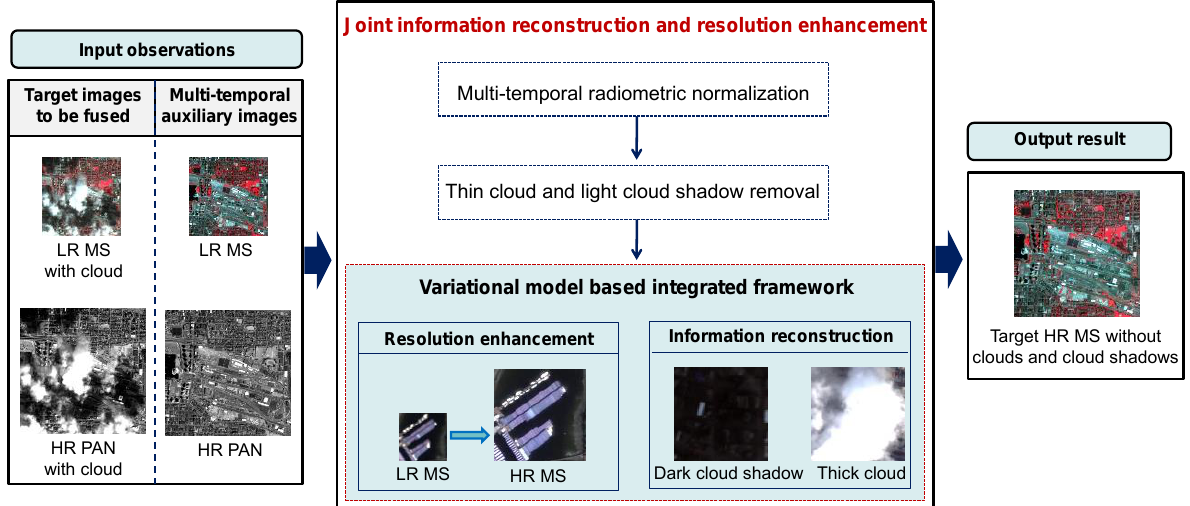
Figure 1. Schematic diagram of the proposed integrated fusion framework for joint information reconstruction and resolution enhancement.